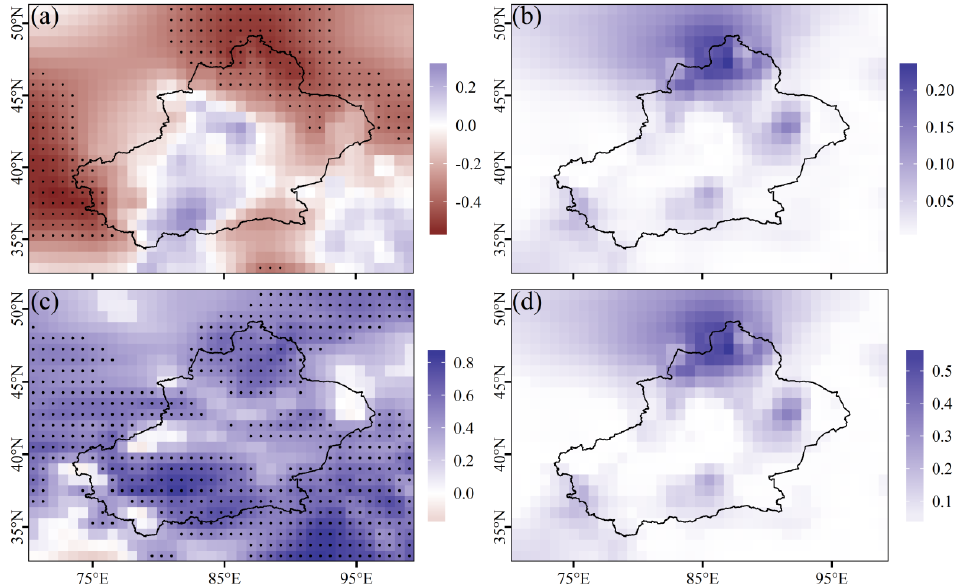
Figure 6. The spatial distribution of results obtained from the correlation and relative weights analyses during the warm season from 1960–2014 over Xinjiang. ( a ) A correlation between lower-tropospheric temperature and light rain days. ( b ) A correlation between lower-tropospheric SH and light rain days. ( c ) The relative weights of lower-tropospheric temperatures to light rain days. ( d ) The relative weights of lower-tropospheric SH to light rain days.